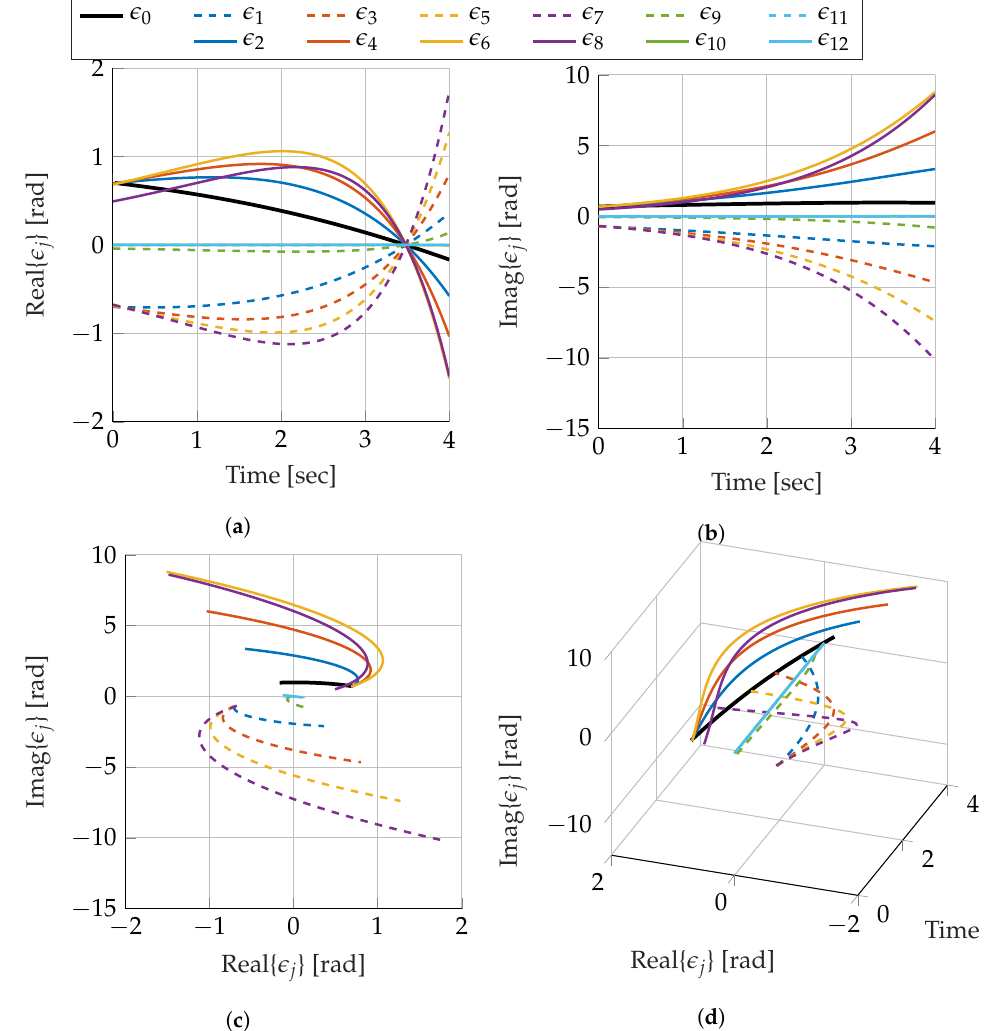
Figure 8. Time evolution of the first 13 chaos coefficients describing the random variable φ . ( a ) Real Coefficient Evolution. ( b ) Imaginary Coefficient Evolution. ( c ) Imaginary and Real Coefficient Evolution. ( d ) Complex Coefficient